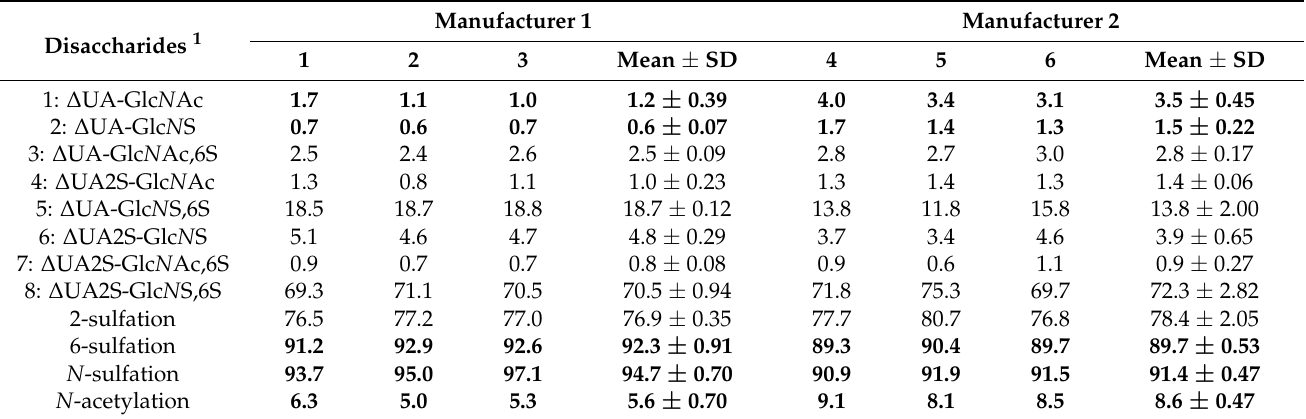
Table 4. Proportions (% of total) of the disaccharides formed by the digestion of pharmaceutical heparins from two manufacturers with a mixture of heparinases I, II, and